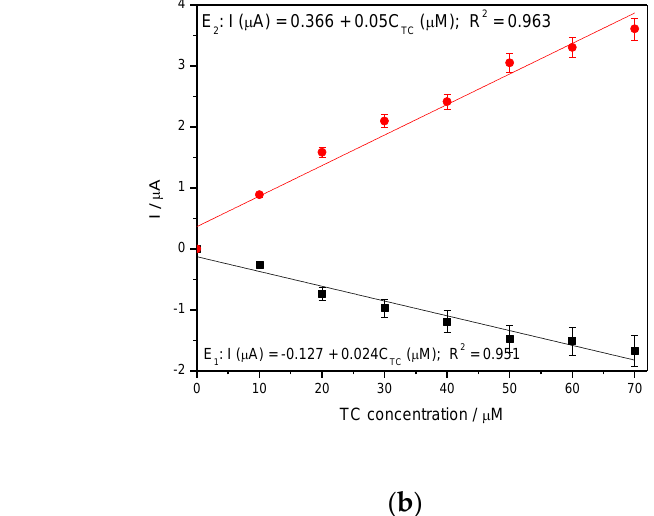
Figure 13. ( a ) Multiple-pulsed amperometry (MPA) recorded at Ag/GO/BDD electrode in 0.1 M NaOH supporting elec- trolyte, in the presence of 10-70 µM TC concentration: 10 µM, 20 µM, 30 µM, 40 µM, 50 µM, 60 µM, 70 µM at two applied potential levels, i.e. E 1 = +0.300 V/SCE and E 2 = − 0.150 V/SCE. ( b ) Calibration plots for tetracycline detection in the concen- tration range 10-70 µM recorded at the potential E 1 = − 0.150 V/SCE and E 2 = +0.300 V/SCE.